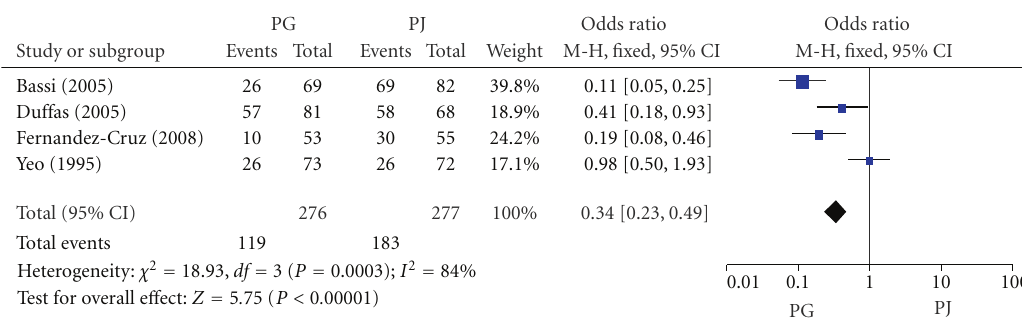
Figure 2: Forest plot of morbidity of IACs between PG and PJ.